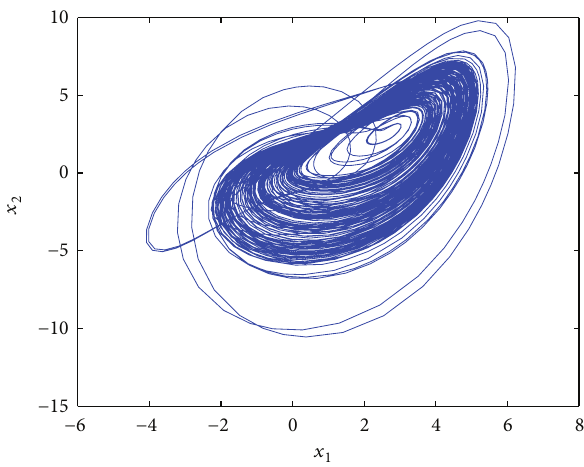
Figure 9: Period-doubling bifurcation in 𝑥 1 − 𝑥 2 plane (𝑢 = 3.1) .